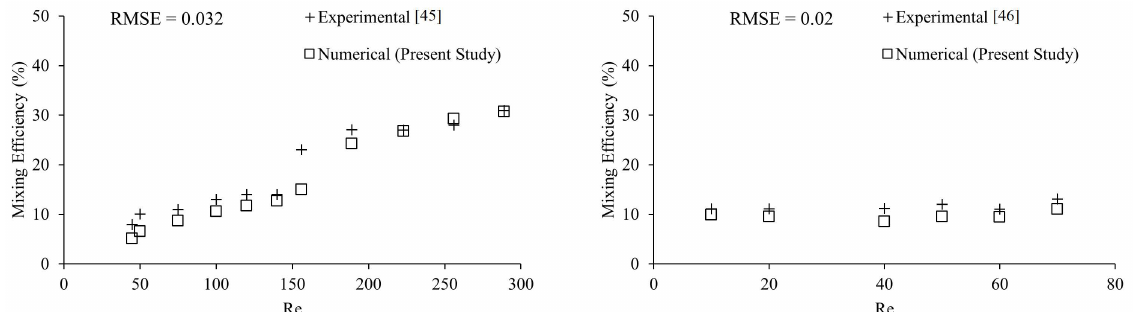
Figure A3. CFD code validation results. Numerical simulation outcomes (present study) against experimental data of two different T-shaped passive micromixers. Root mean square error (RMSE) is used to measure the fit of the numerical simulation results to the experimental data.